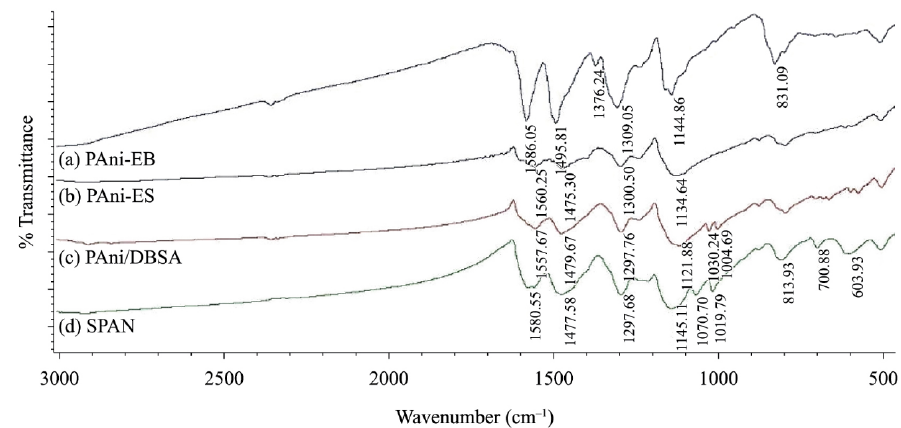
Figure 1. FTIR spectra of (a) PAni-EB; (b) PAni-ES; (c) PAni/DBSA; (d)